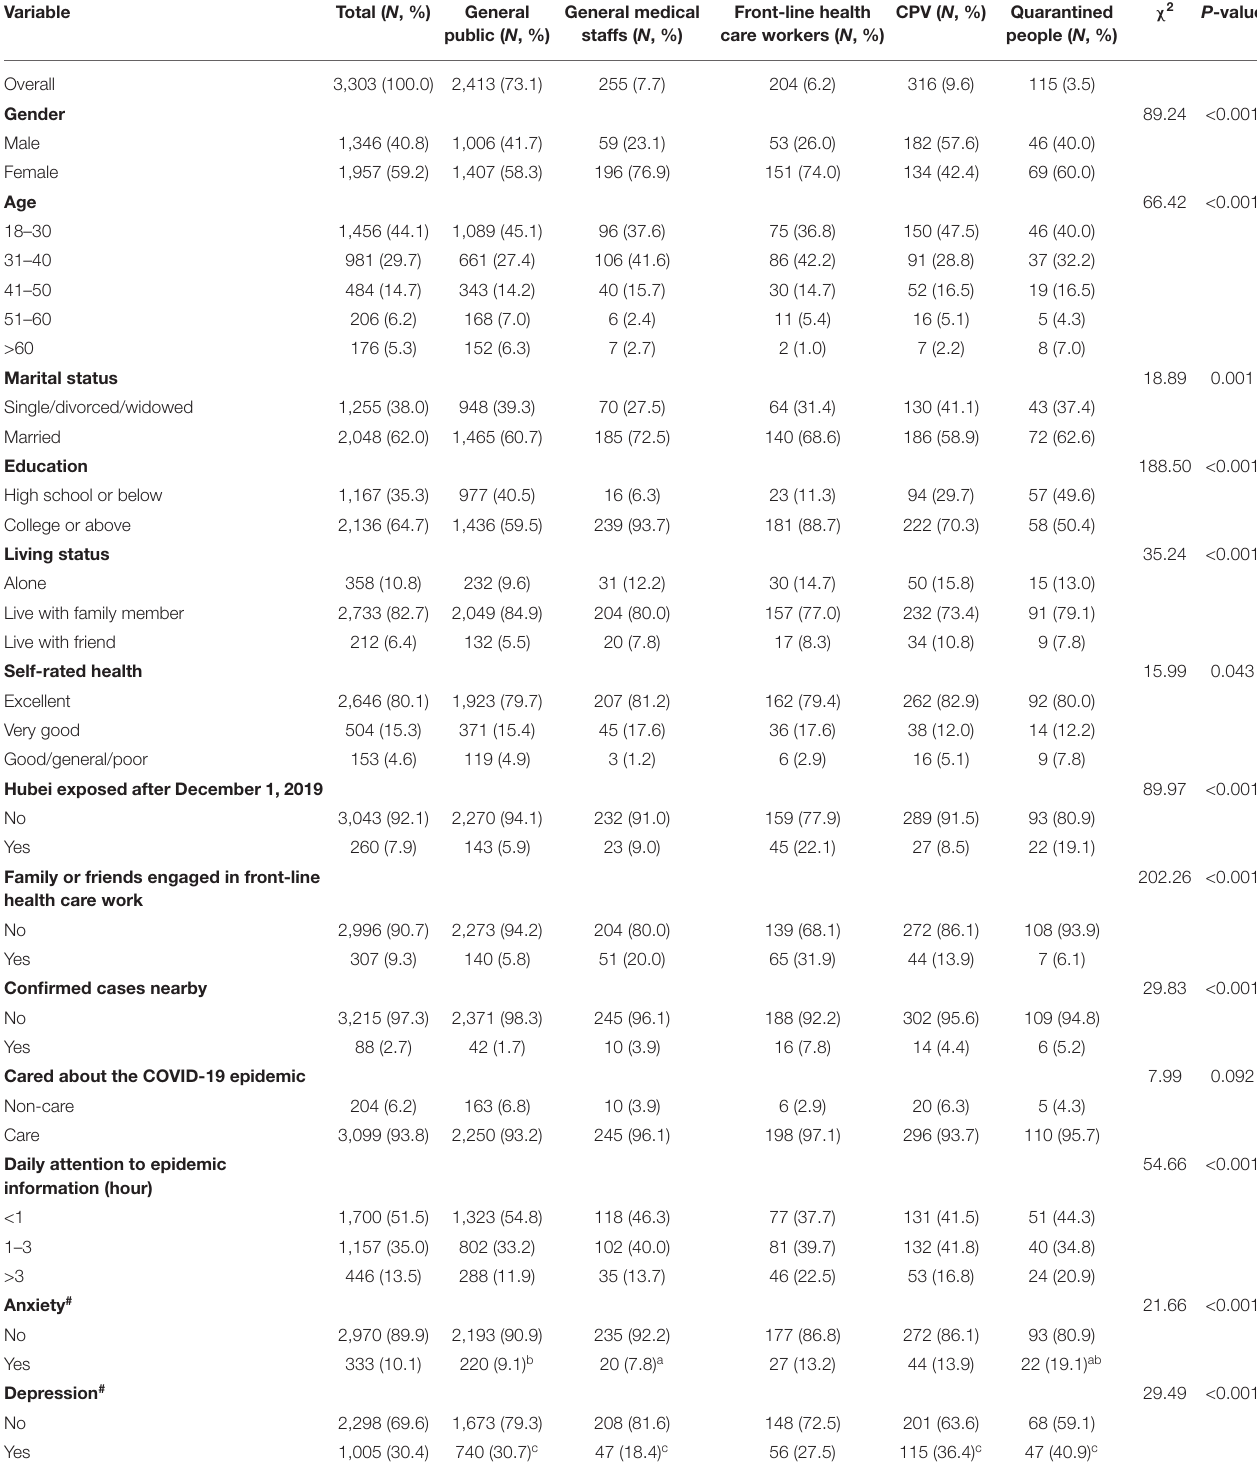
TABLE 1 | Demographic characteristics of